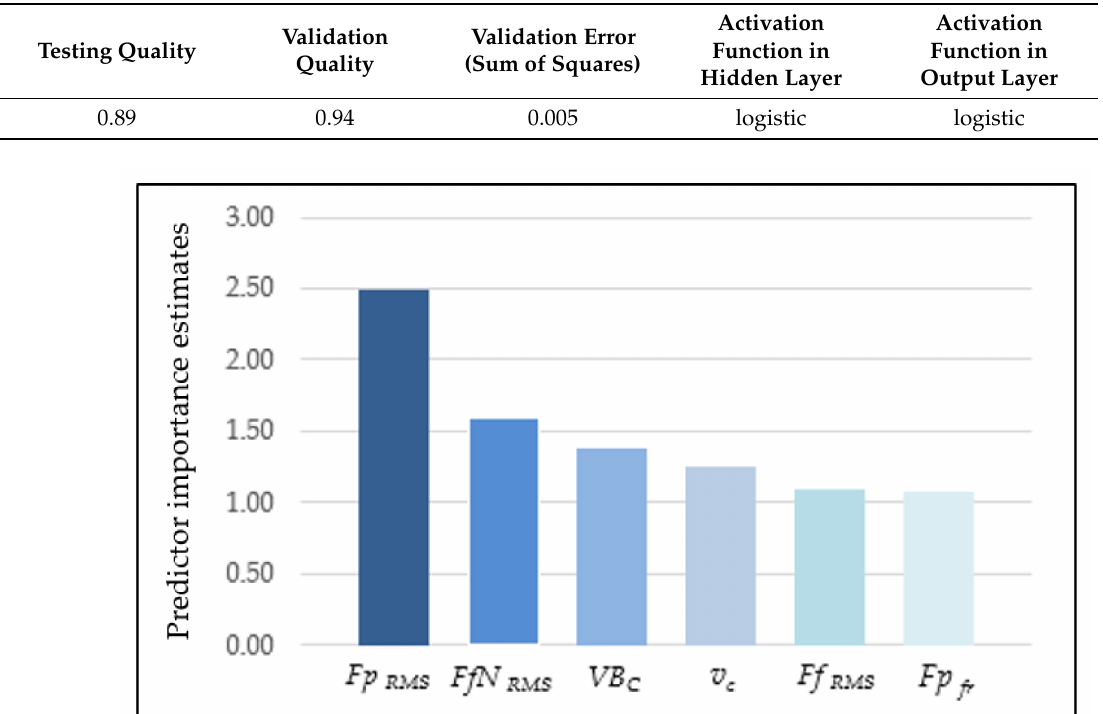
Table 4. Structure of MLP model.